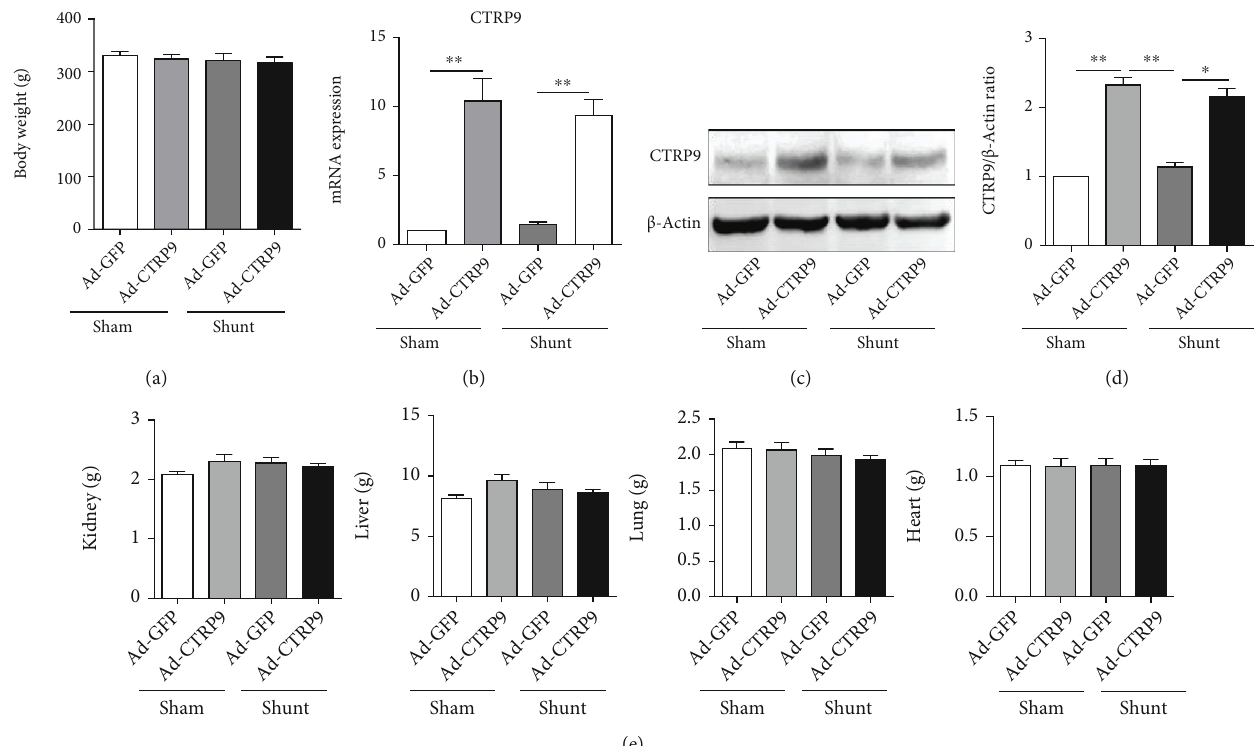
Figure 1: E ff ects on physical parameters following CTRP9 overexpression in sham and shunt rats. (a) The body weight and the weights of the lung, heart, liver, and kidney of rats. (b) mRNA expression of CTRP9 was measured by RT-qPCR in the shunt and sham groups. (c) Protein expression of CTRP9 was determined by western blotting ( β -actin was loaded as the control). n = 10 of each group. Mean ± SEM . ∗ P < 0 : 05 and ∗∗ P < 0 : 01 vs. the Ad-GFP-sham group. RT-qPCR: reverse transcription-quantitative PCR; CTRP9: C1q/TNF-related protein 9; Ad-GFP: adenovirus-green fl uorescent